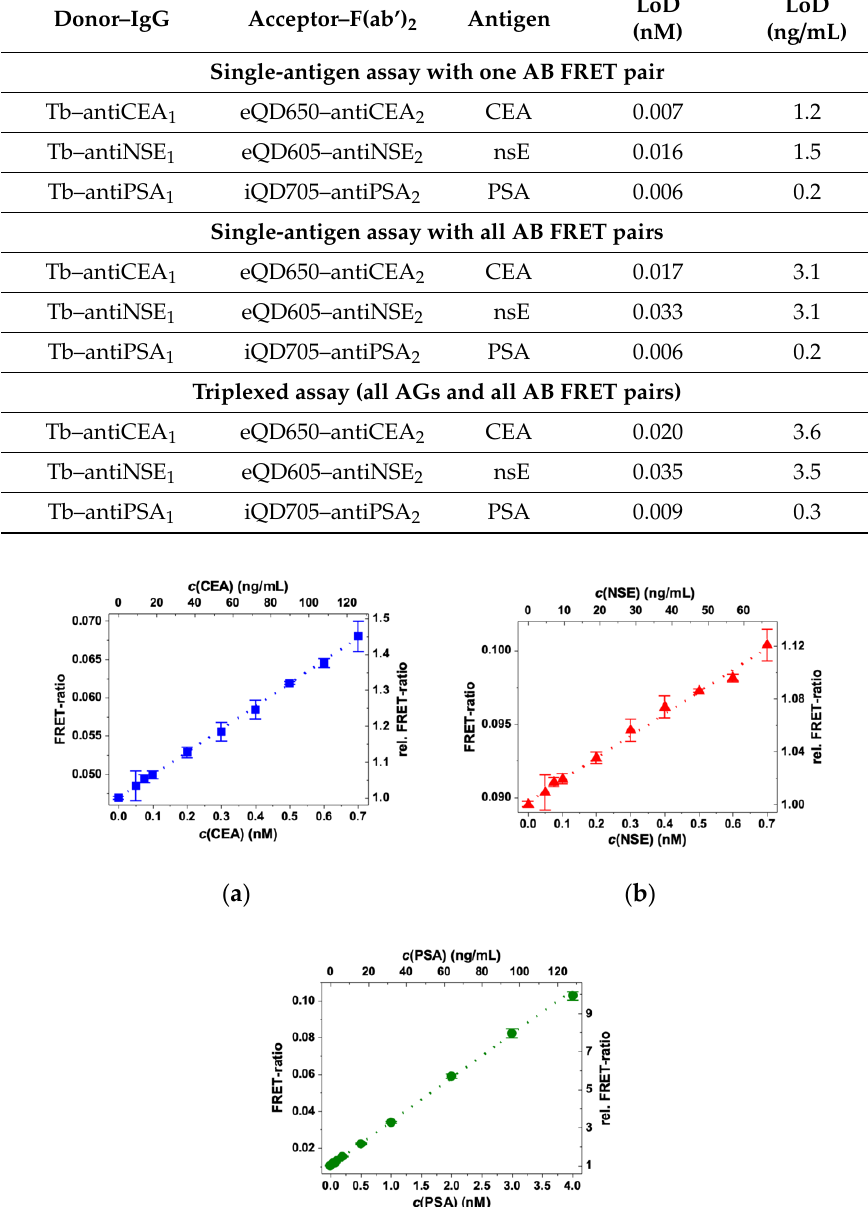
Table 3. LoDs overview of singleplex, “singleplex”, and triplex format of the FRET immunoassays. All the LoDs are below the clinical cut-o ff levels: 5.0 ng / mL for CEA, 12.5 ng / mL for nsE, and 4.0 ng / mL for PSA.